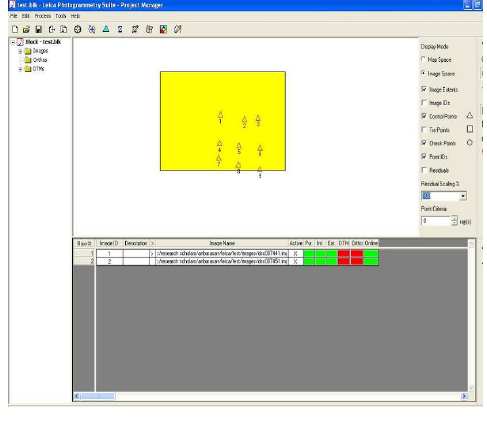
Figure 3: Project Manager in LPS - GCP